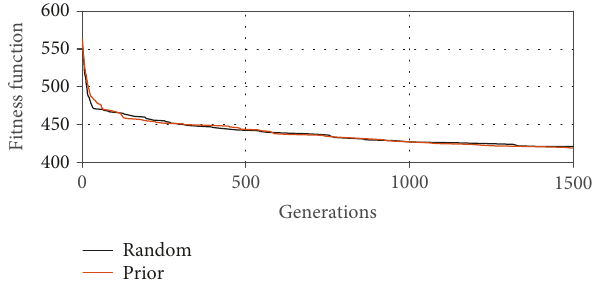
Figure 11: Evolution of the fi tness function of strategy 4 through generations.